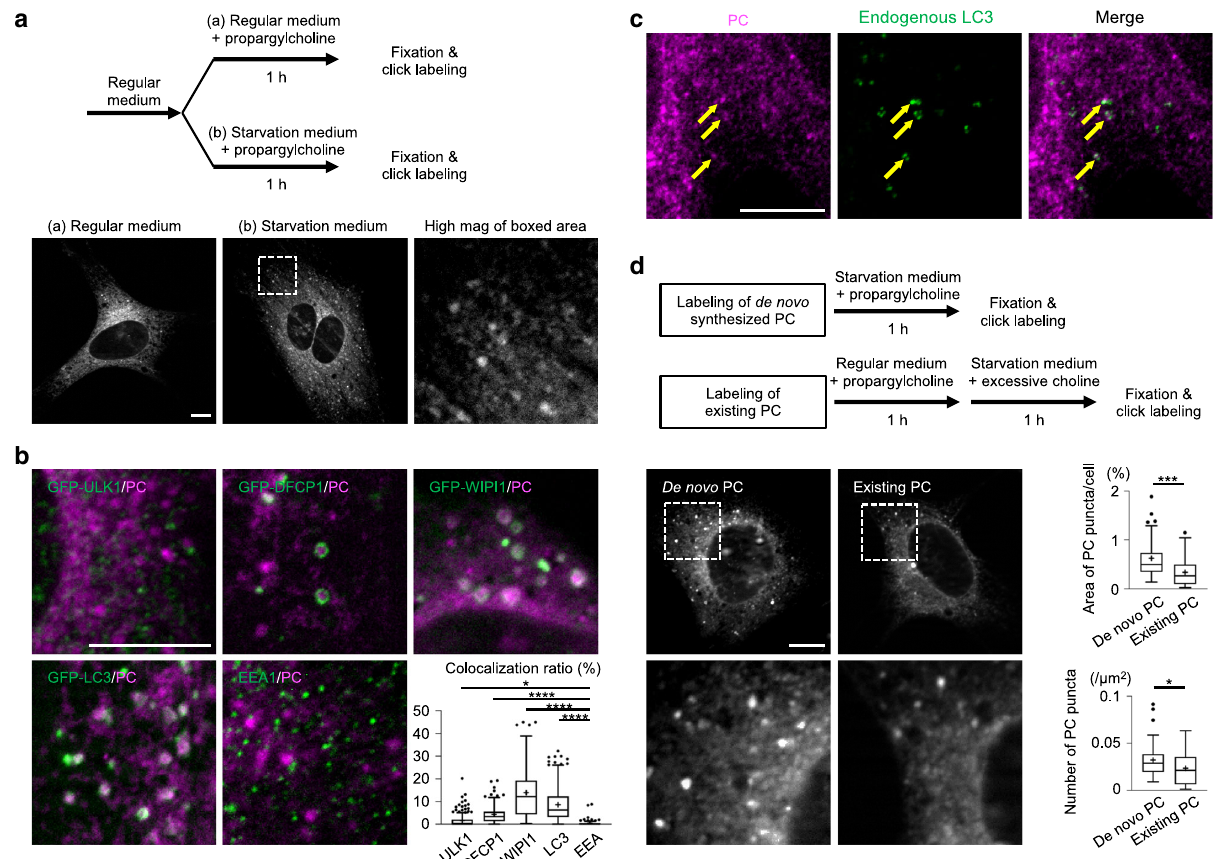
Fig. 1 De novo-synthesized PC and autophagic membranes. a Labeling of de novo-synthesized PC. MEFs were cultured for 1 h with 0.25 mM propargylcholine in regular medium (a) or in starvation medium (b), fi xed, and reacted with Cy3-azide for fl uorescence microscopy. Bar, 10 μ m. b De novo- synthesized PC and GFP-tagged Atg proteins in MEFs starved for 1 h. PC (magenta) and Atg proteins (green): GFP-ULK1, GFP-DFCP1, GFP-WIPI1, and GFP- LC3. Endogenous EEA1 is labeled as a control. Bar, 10 μ m. The box plot shows the ratio of Atg protein (and EEA1) pixels colocalizing with PC puncta. Pooled data from three independent experiments ( n > 130); * p = 0.0042, **** p < 0.0001 (two-tailed Mann – Whitney test). c Double labeling of de novo- synthesized PC (magenta) and endogenous LC3 (green) in MEFs starved for 1 h. Bar, 10 μ m. d Labeling of existing PC. MEFs were cultured for 1 h with 0.25 mM propargylcholine in regular medium and then for the next 1 h with 5 mM choline in starvation medium. Bar, 10 μ m. The total area and the number of PC puncta in a cell were measured. Pooled data from three independent experiments ( n = 40); * p = 0.0367, *** p = 0.0002 (two-tailed Mann – Whitney test). In box plots, the center line indicates the median, box boundaries indicate the 25th and 75th percentiles, whiskers are Tukey-type, and the average is marked as + . Source data are provided as a Source data fi